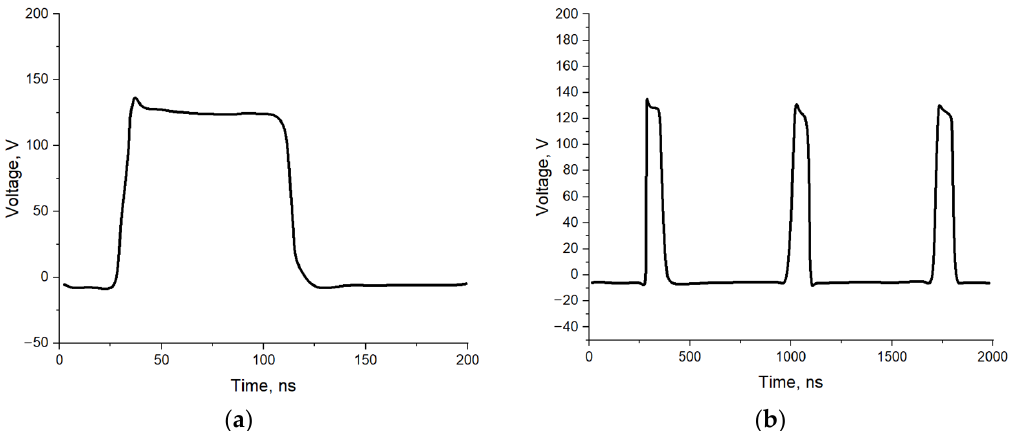
Figure 10. Measured shape of a single HV pulse with FSWP-51-02 at the load, showing achieved 6.5 ns rise and 5.9 ns fall times ( a ) and the load voltage pulses, showing achieved 1.4 MHz PRF ( b ).